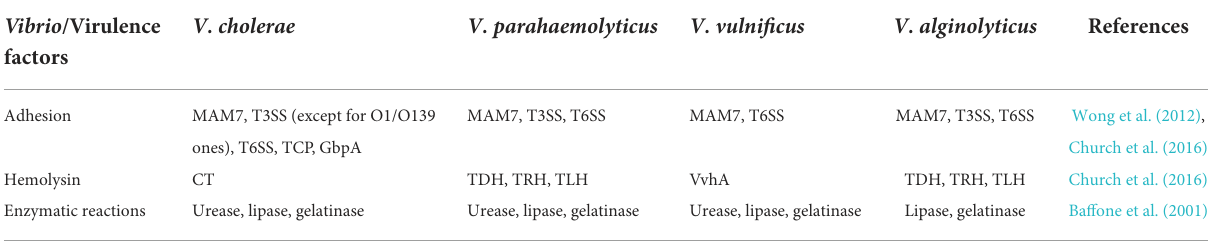
TABLE 1 Different virulence factors of Vibrio species during the infection